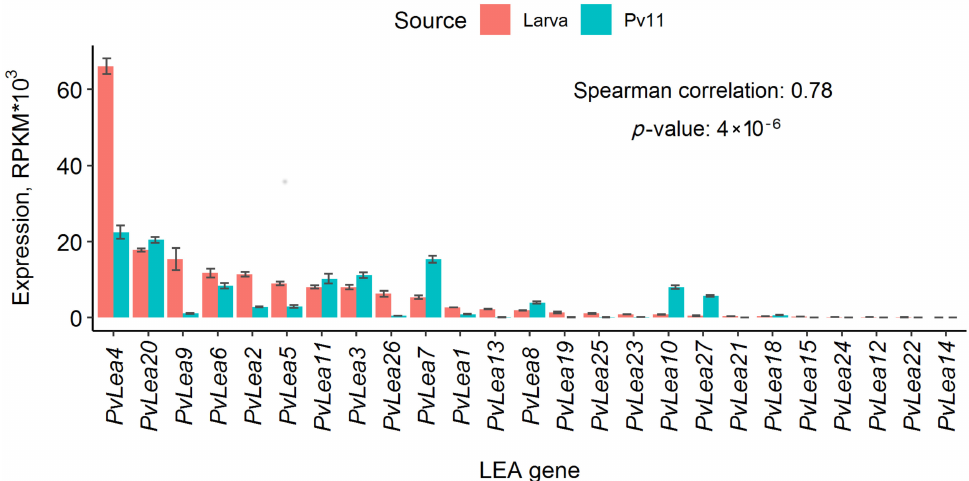
Figure 1. PvLea expression in reads per kilobase of exon per million mapped sequence reads (RPKM) in P. vanderplanki larvae and Pv11 cells after 24 h of anhydrobiosis induction. The height of the bars depicts the expression mean of replicates; error bars show corresponding standard deviations. The colors of the bars indicate data for larvae (red) or Pv11 cells (blue-green). Genes are ordered in accordance with expression in P. vanderplanki larvae, and their IDs are placed below the plot. The text indicates the Spearman correlation values of mean gene expression values between Pv11 cells and P. vanderplanki larvae and corresponding p